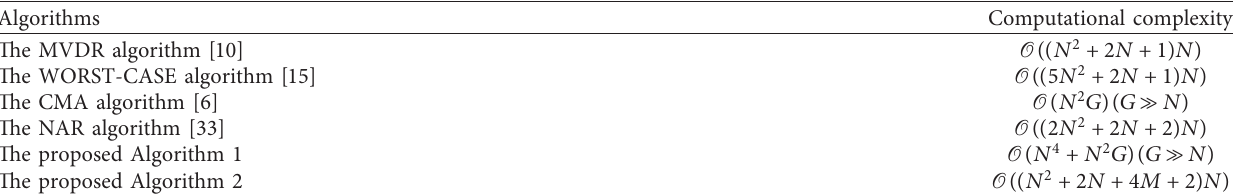
Table 1: Comparison of computational